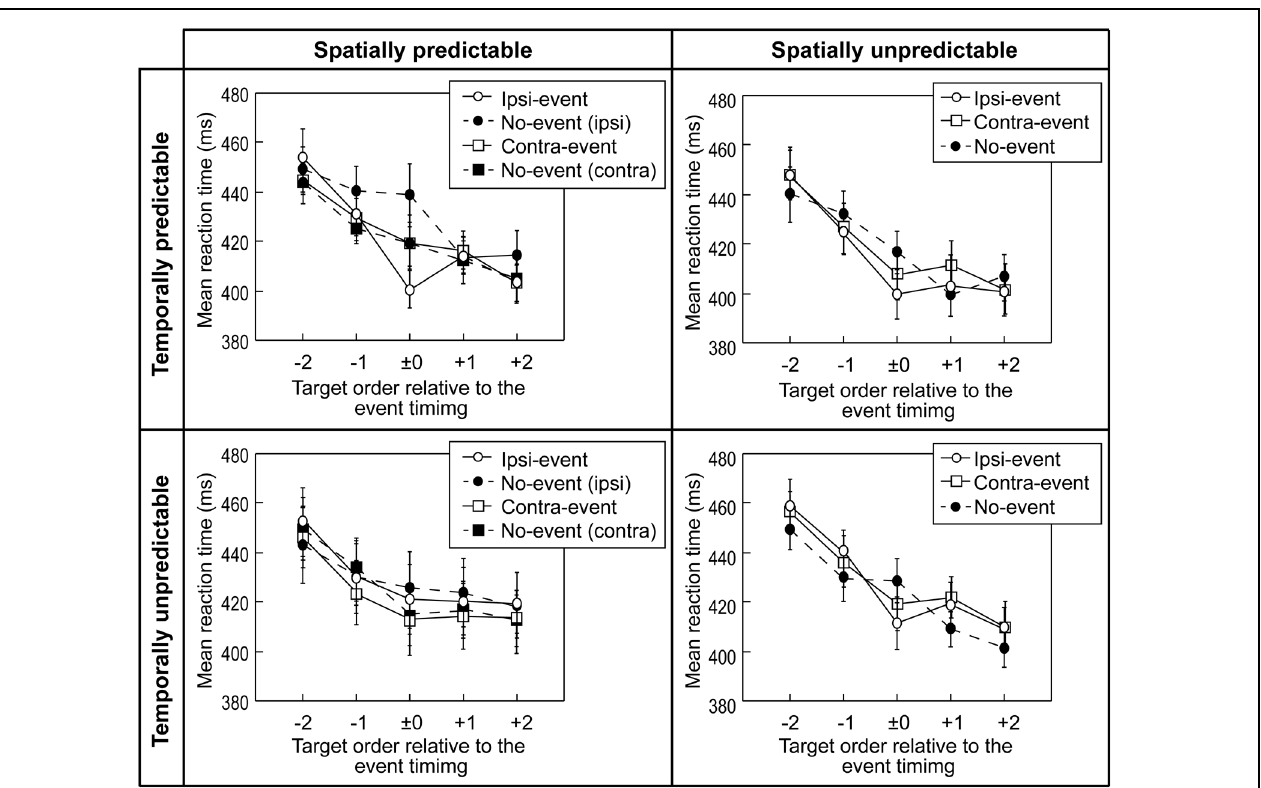
FIGURE 3 | Results of the target detection task in the four experiments. Mean RTs (averaged over the participants) for correct detections are plotted as a function of the temporal position of the target letter relative to the event timing (designated as zero on the abscissa). Error bars denote the standard errors of the means. No-event (ipsi) is the no-event data in the ipsi-lateral event block, No-event (contra) is the no-event data in the contra-lateral event